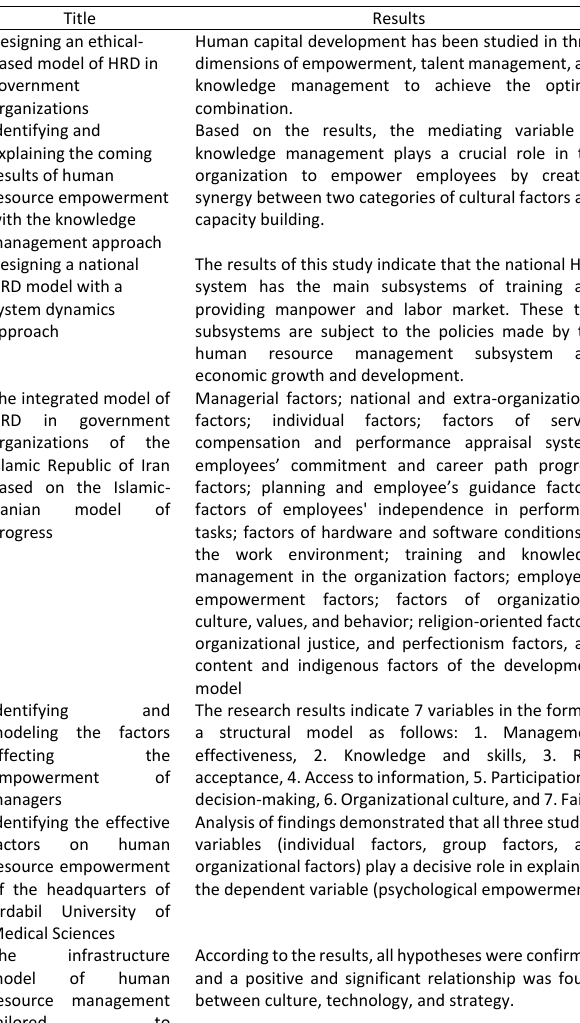
Table 1. A summary of the literature review